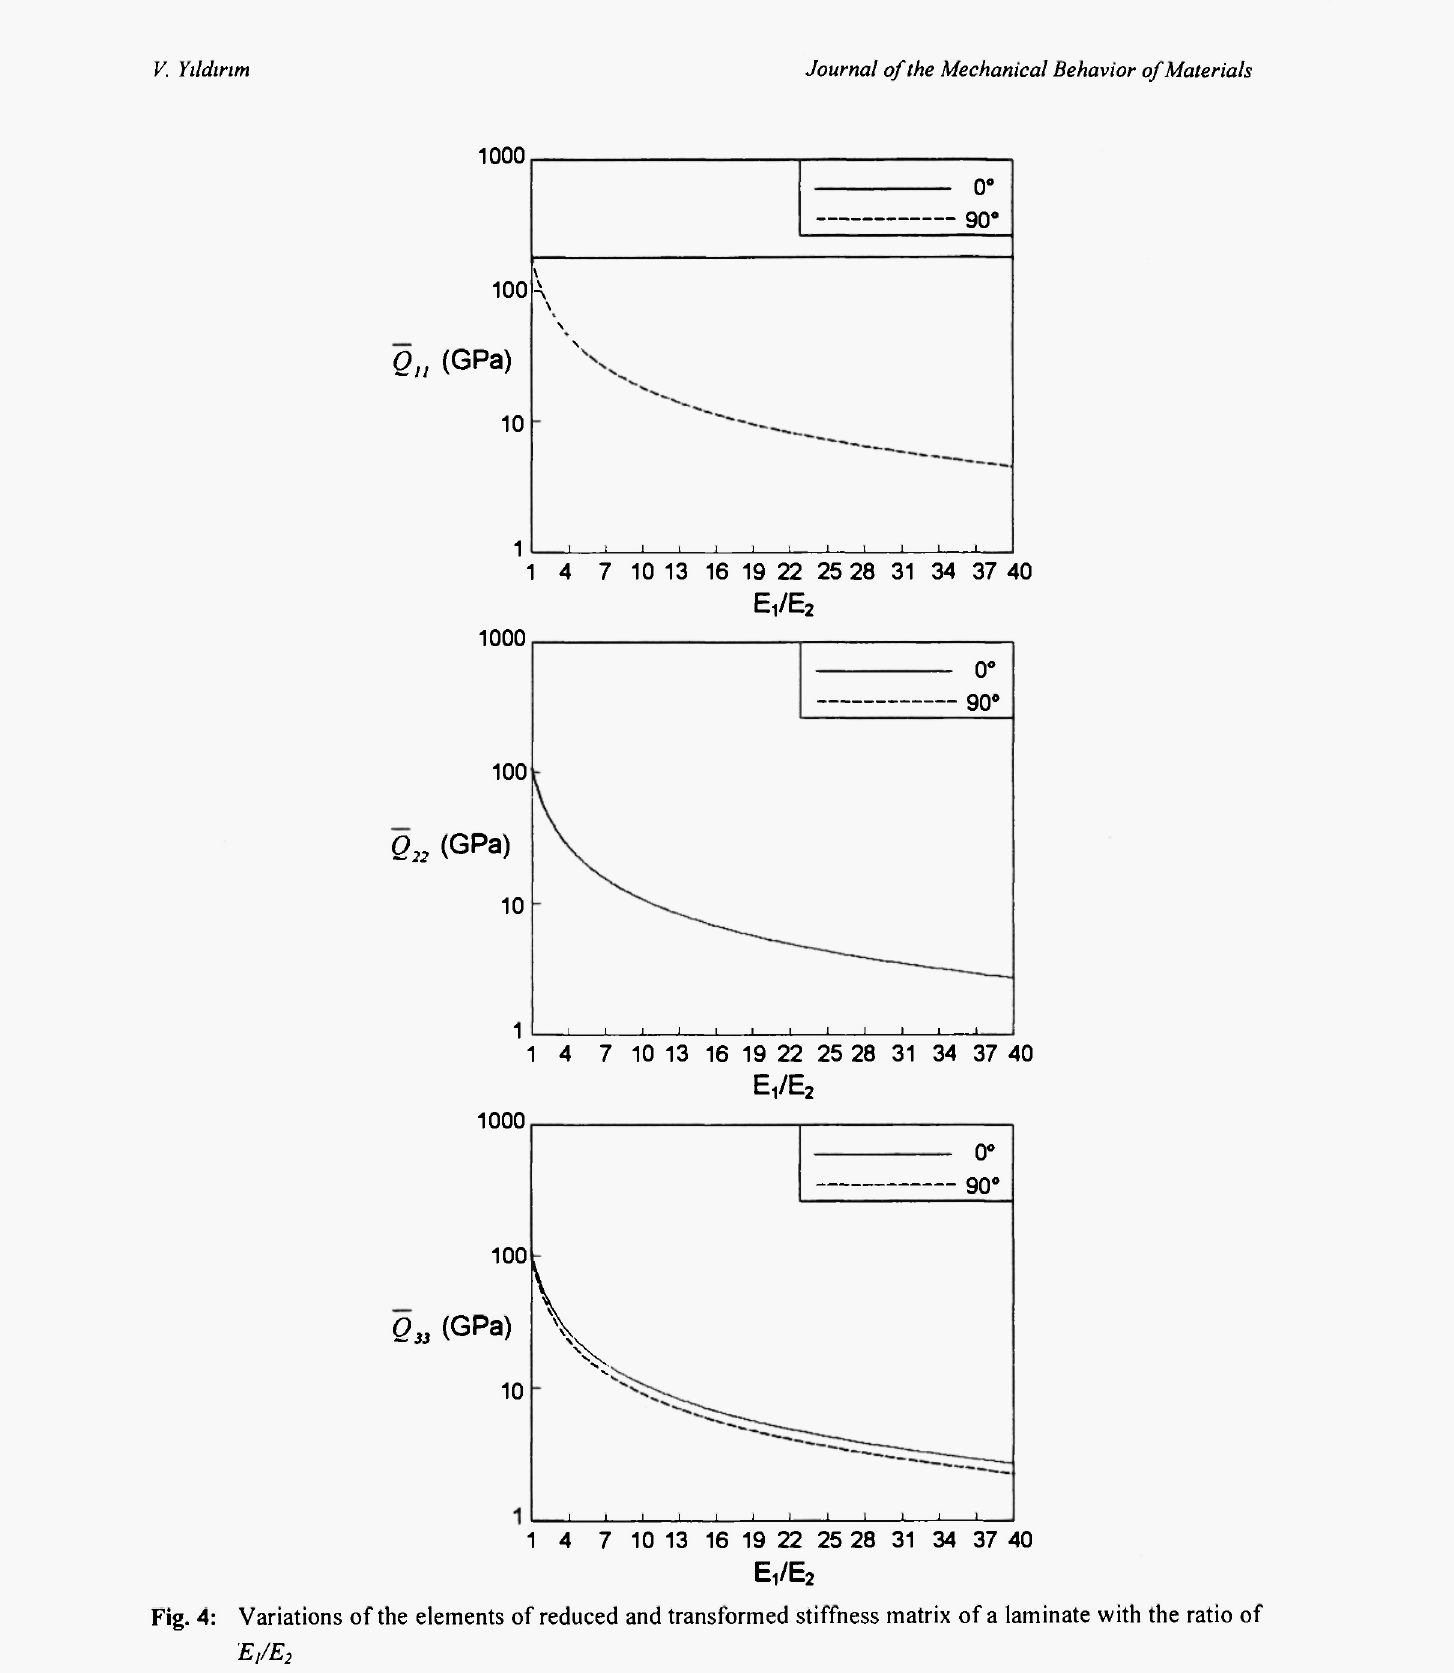
Fig. 4: Variations of the elements of reduced and transformed stiffness matrix of a laminate with the ratio of E,/E 2